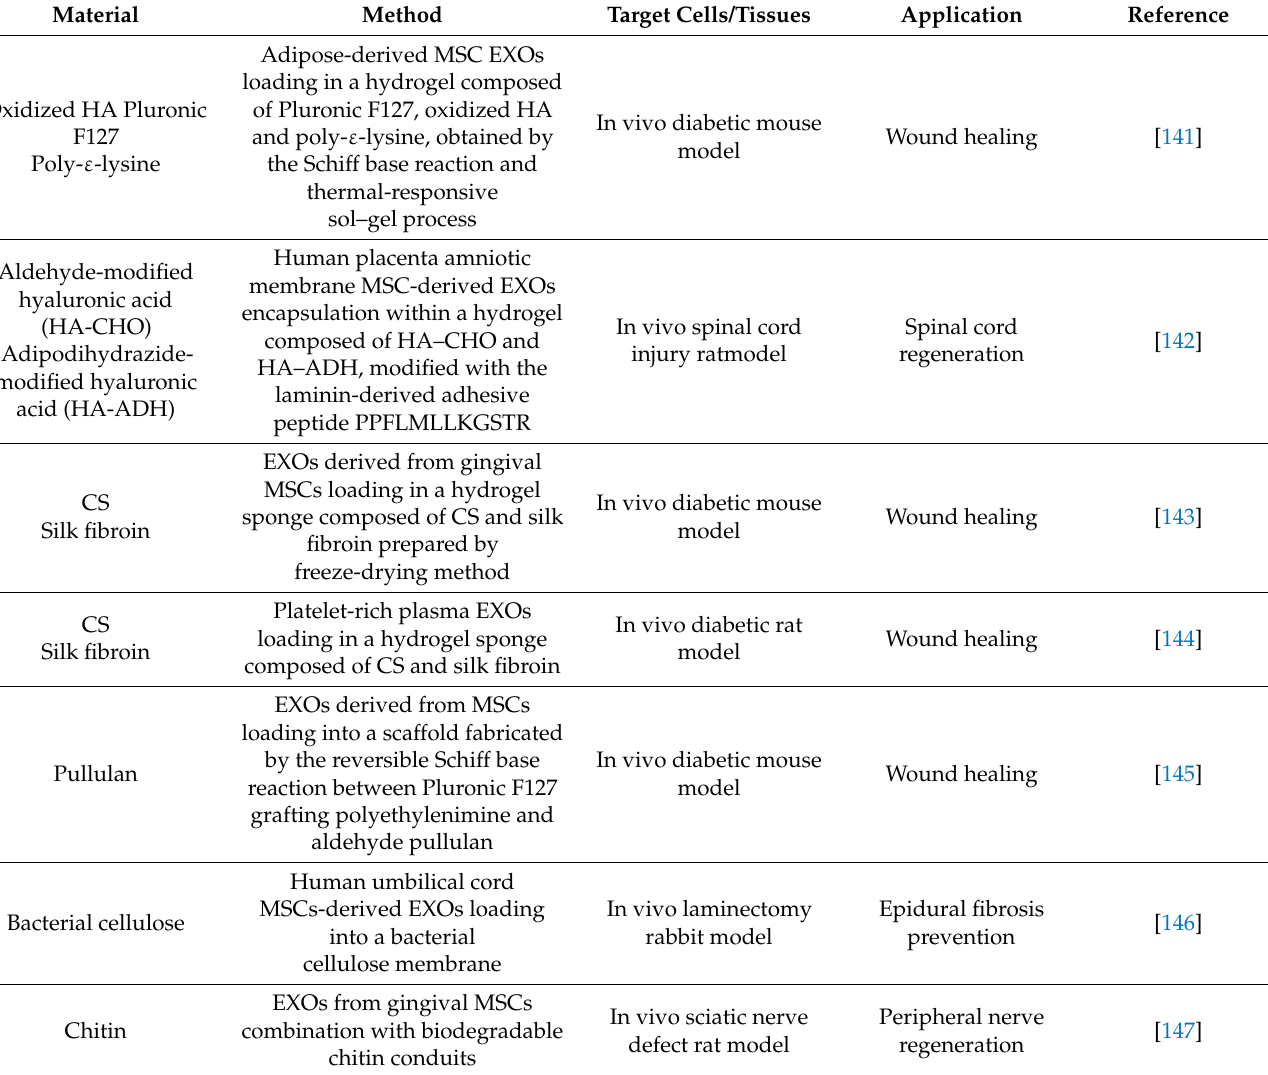
Table 4. Polysaccharide-based pre-formed hydrogels for sustained delivery of